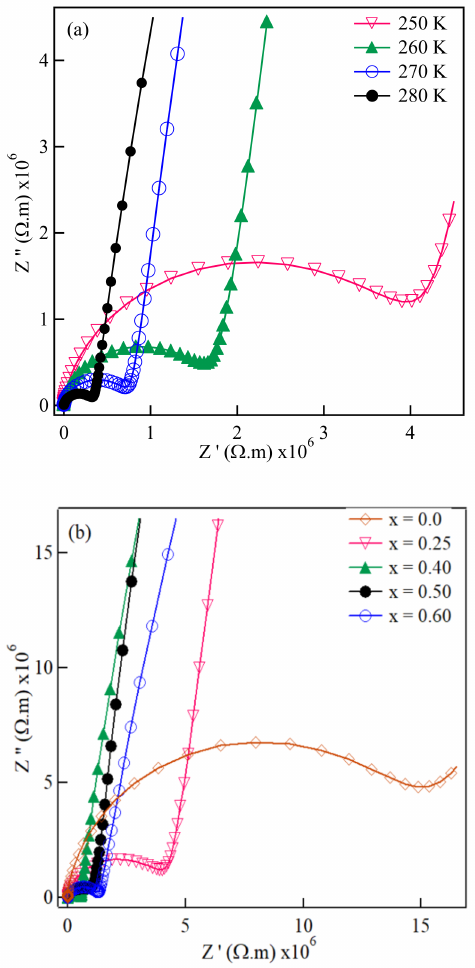
Figure 2. Complex impedance diagrams for ( a ) Li 5.5 La 3 Nb 1.75 Sm 0.25 O 12 garnets at selected tempera- ture and ( b ) for the different samples at 250 K.